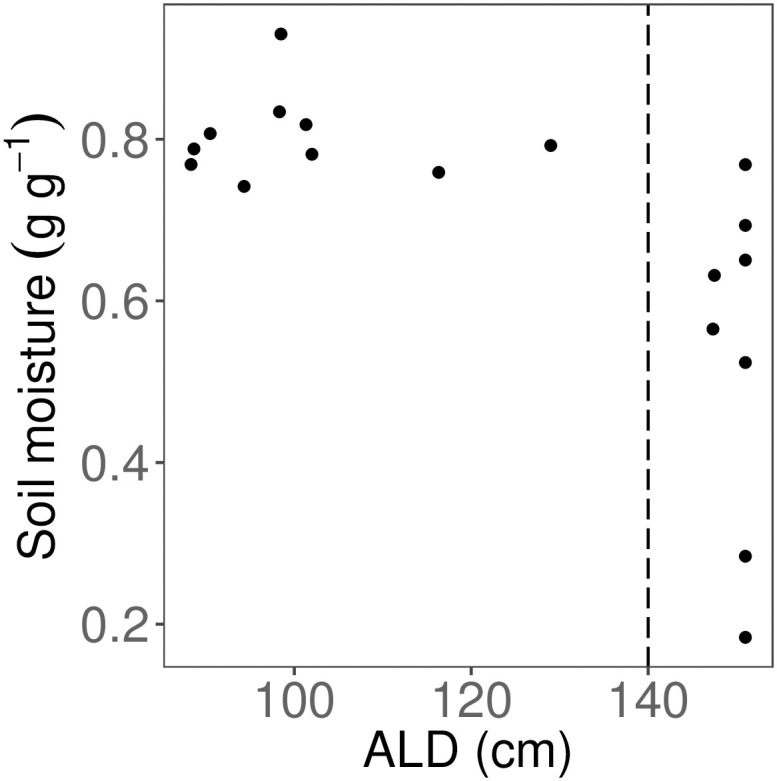
Relationship between active layer depth (ALD) and gravimetric soil moisture.Only 6 cm soil depth was used. Vertical dashed line indicates cut-off for shallow (< 140 cm) and deep (> 140 cm) ALD classes.